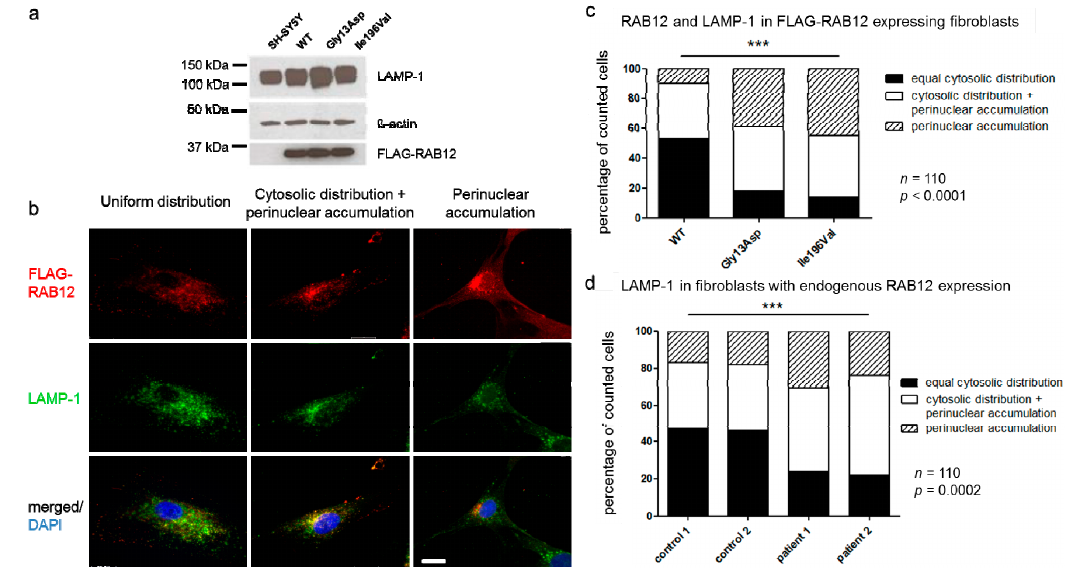
Figure 3. RAB12 mutations changed the subcellular localization of RAB12 proteins and lysosomes. ( a ) Ectopical protein expression of FLAG-RAB12 and expression of the lysosome-associated protein LAMP-1 (lysosomal associated membrane protein 1) is equal in RAB12 WT and mutant SH-SY5Y cells. All protein signals were detected on the same membrane. Blots were cropped for clarity but no bands were removed. Original blots are shown in the supplementary material (Figure S5); ( b ) In WT and mutated RAB12-overexpressing cells, three different patterns of RAB12 distribution were observed and categorized. Proportions of cells revealed RAB12 (red) that was evenly distributed in the cytoplasm (upper left panel), that was distributed in the cytoplasm and accumulated in close proximity to the nucleus (upper middle panel), or that accumulated exclusively in the perinuclear region of the fibroblast (upper right panel). FLAG-RAB12 and LAMP-1 (green) colocalized in the cytoplasm (lower panels). Nuclei were stained with DAPI (blue). Scale bar: 20 µ m; ( c ) 110 randomly chosen fibroblasts with each construct were categorized and cellular localization of FLAG-RAB12 and LAMP-1 was quantified. Chi-square test: p < 0.0001; ( d ) 110 randomly chosen fibroblasts of two MD patients (p.Ile196Val) and two healthy controls were categorized and cellular localization of LAMP-1 was quantified. Chi-square test: p = 0.0002.